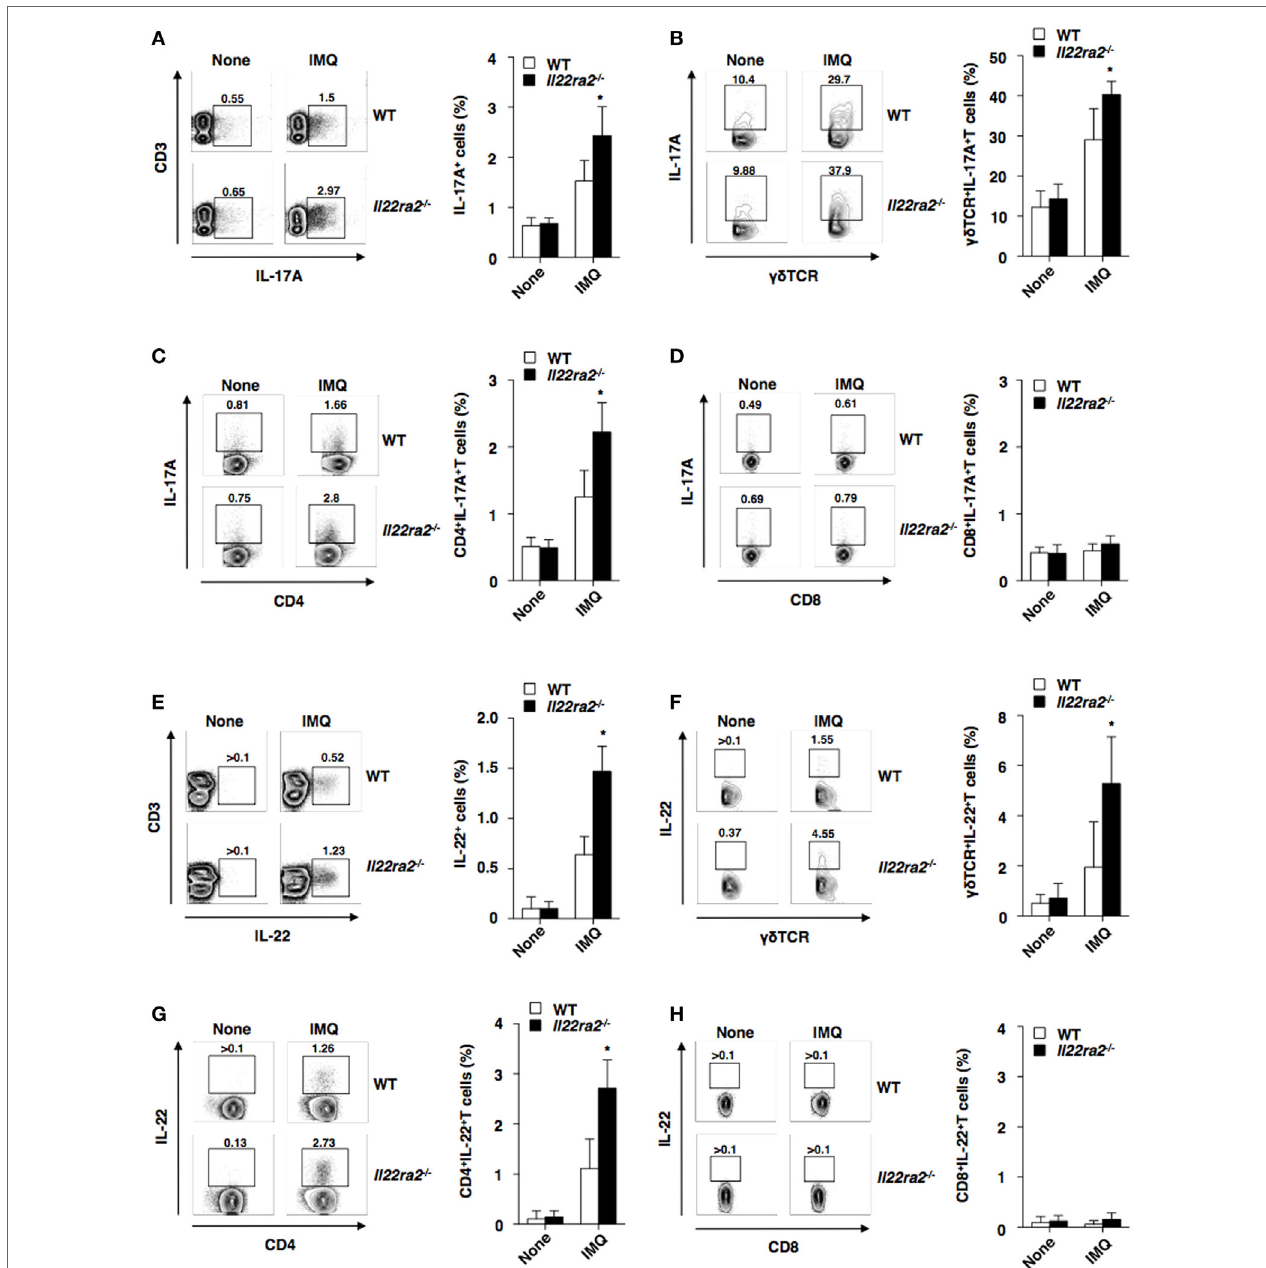
FigUre 5 | IL-22 binding protein deficiency increases the generation of lymphocytes producing interleukin (IL)-17A or IL-22 during the development of psoriatic inflammation. The frequency of IL-17A-producing cells (a–D) and IL-22-producing cells (e–h) among CD3 + T cells (a,e) , γδ TCR + T cells (B,F) , CD4 + T cells (c,g) , and CD8 + T cells (D,h) in the skin-draining peripheral lymph nodes was analyzed by flow cytometry at days 0 and 8 after topical application of imiquimod (IMQ) on the ear skin in wild-type (WT) mice ( n = 5) and Il22ra2 − / − mice ( n = 5). Data are presented as a contour plot, and numbers represent the proportion of the indicated cell populations in each gate (left panel). Data are the mean ± SD from five individual samples in a single experiment (right panel). * P < 0.01 compared with WT mice. All data are representative of at least three independent